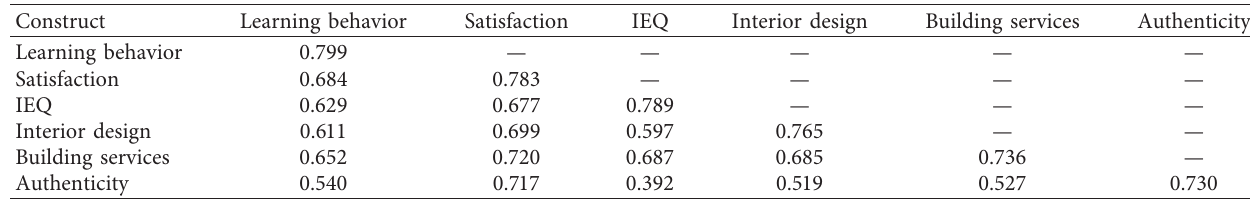
Table 6: Discriminant validity